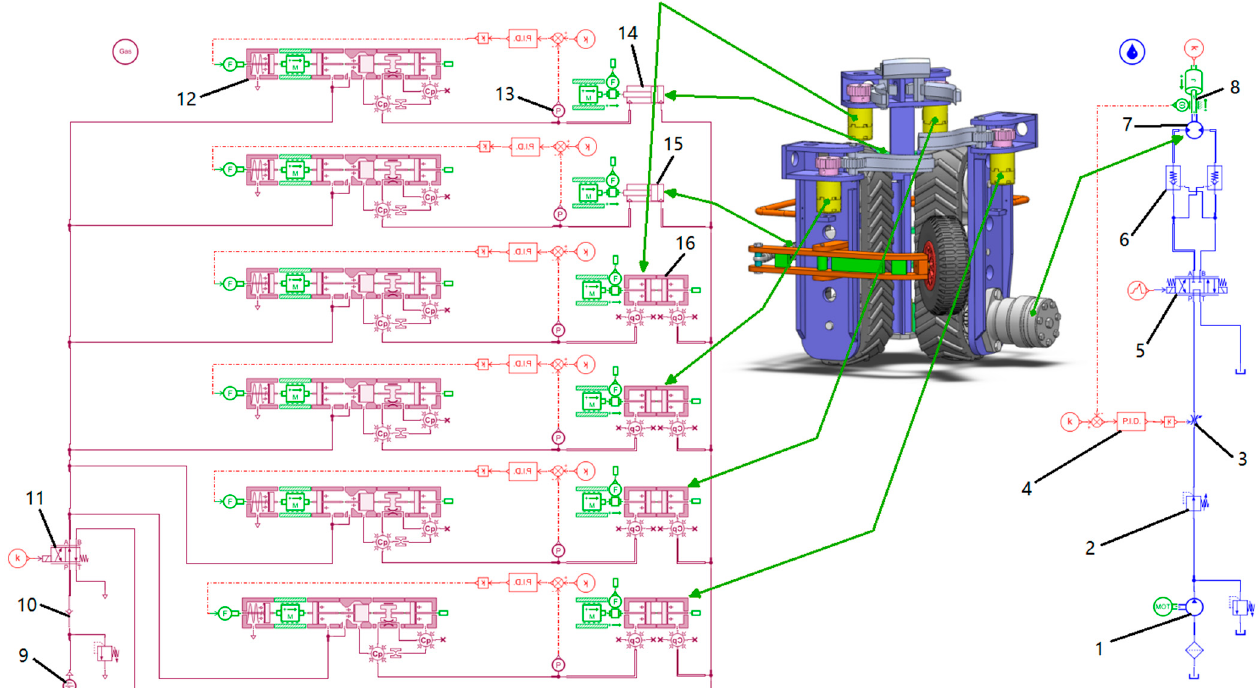
Figure 9. Hydraulic and pneumatic principles: 1—hydraulic Station; 2—pressure-reducing valve; 3— variable throttle valve; 4—PID control; 5—three-position four-way directional valve; 6—hydraulic lock; 7—hydraulic motor; 8—encoder; 9—air compressor; 10—one-way valve; 11—two-position four-way directional valve; 12—proportional pressure-reducing valve; 13—pressure sensors; 14—clamping cylinder; 15—barrier avoidance cylinder; 16—oscillating cylinder.